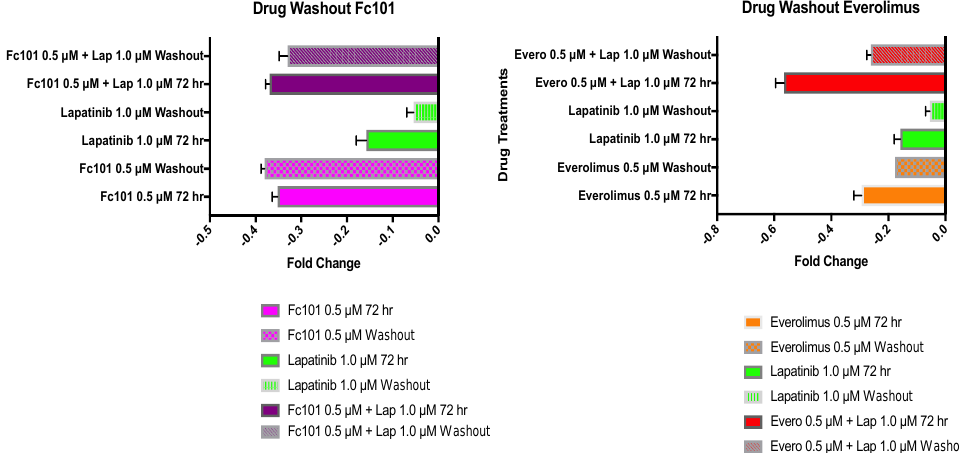
Figure 7. Drug washout assay. Fold changes in viability for the 72 h treatment period are graphed alongside viability fold changes for the 72 h recovery period after drug washout. Solid bars represent the 72 h treatment conditions; patterned bars represent the drug washout conditions. Treatment concentrations included FC101 (0.5 μM), lapatinib (1.0 μM), everolimus (0.5 μM), and combinations of FC101 or everolimus with lapatinib.